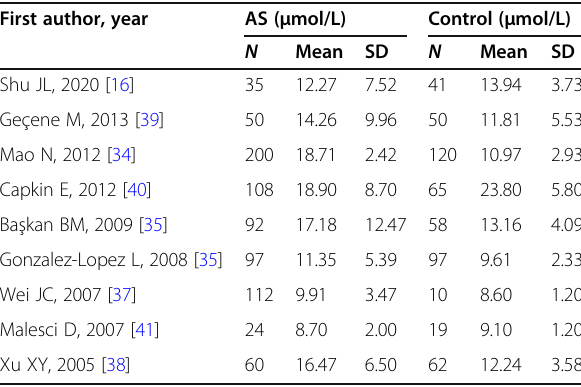
Table 2 Extracted data on HCY levels of 9 studies